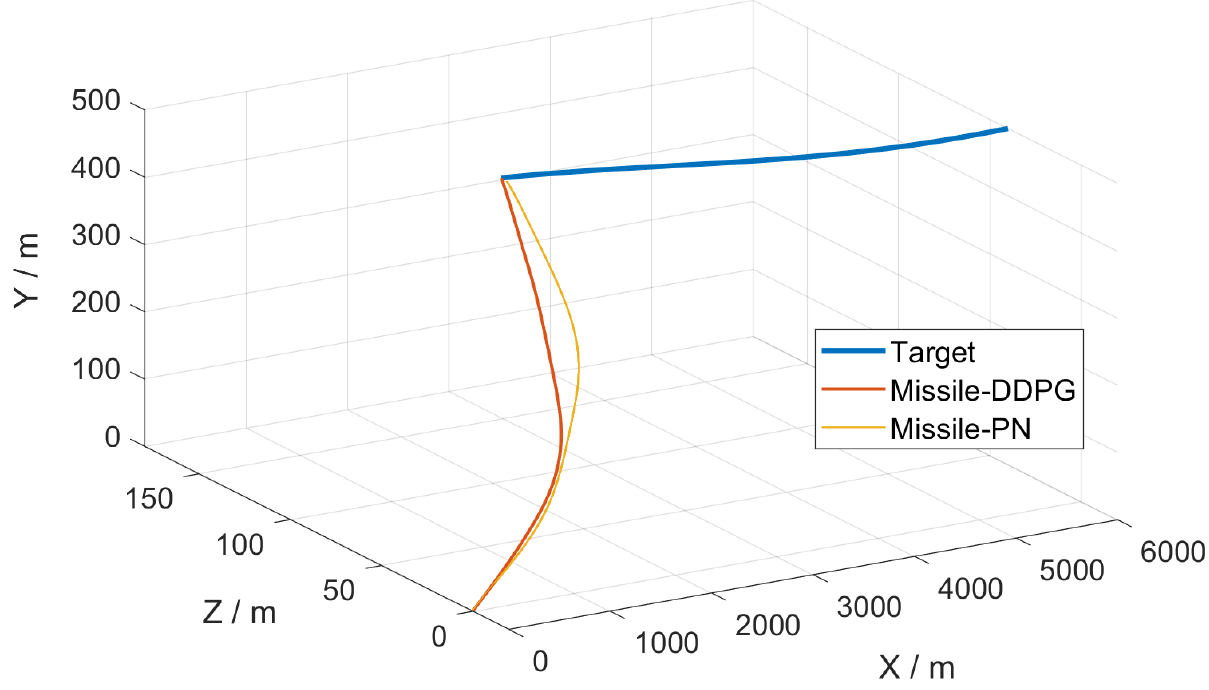
Figure 4. Missile – target 3D trajectory diagram (Scenario 1). Figure 4. Missile–target 3D trajectory diagram (Scenario